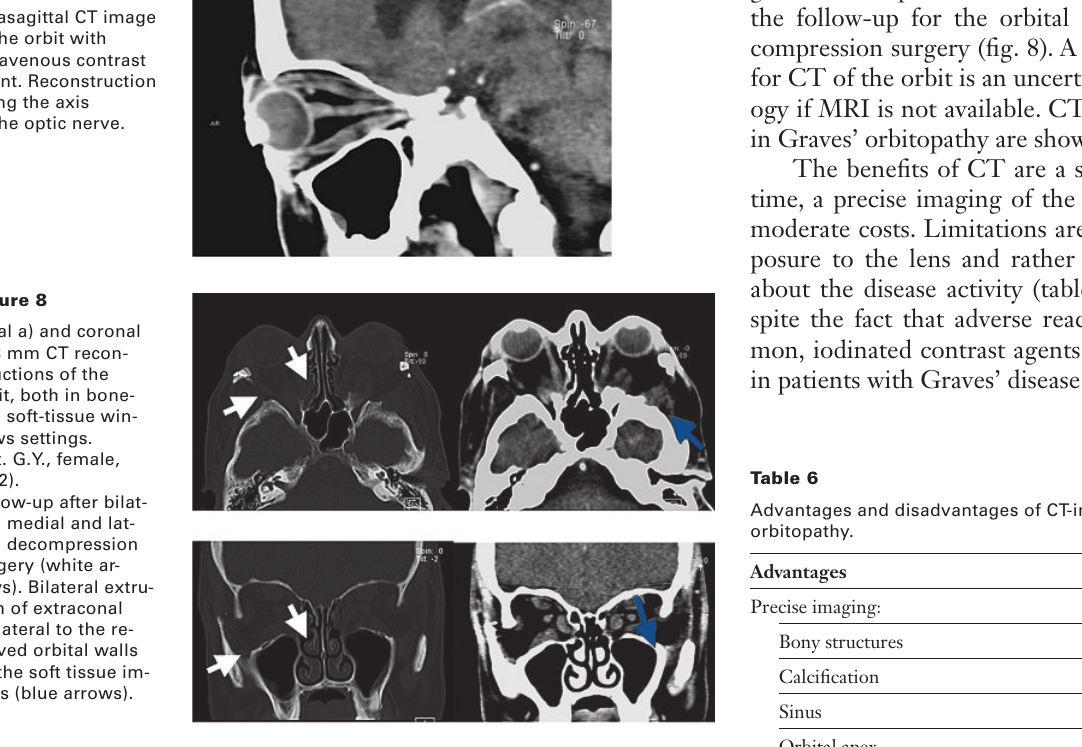
Parasagittal CT image of the orbit with intravenous contrast agent. Reconstruction along the axis of the optic nerve.